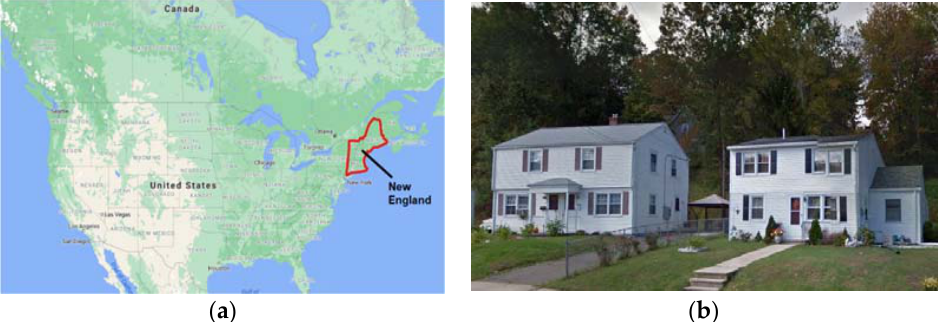
Figure 1. ( a ) Map of New England in the US; ( b ) views of one of the case study buildings